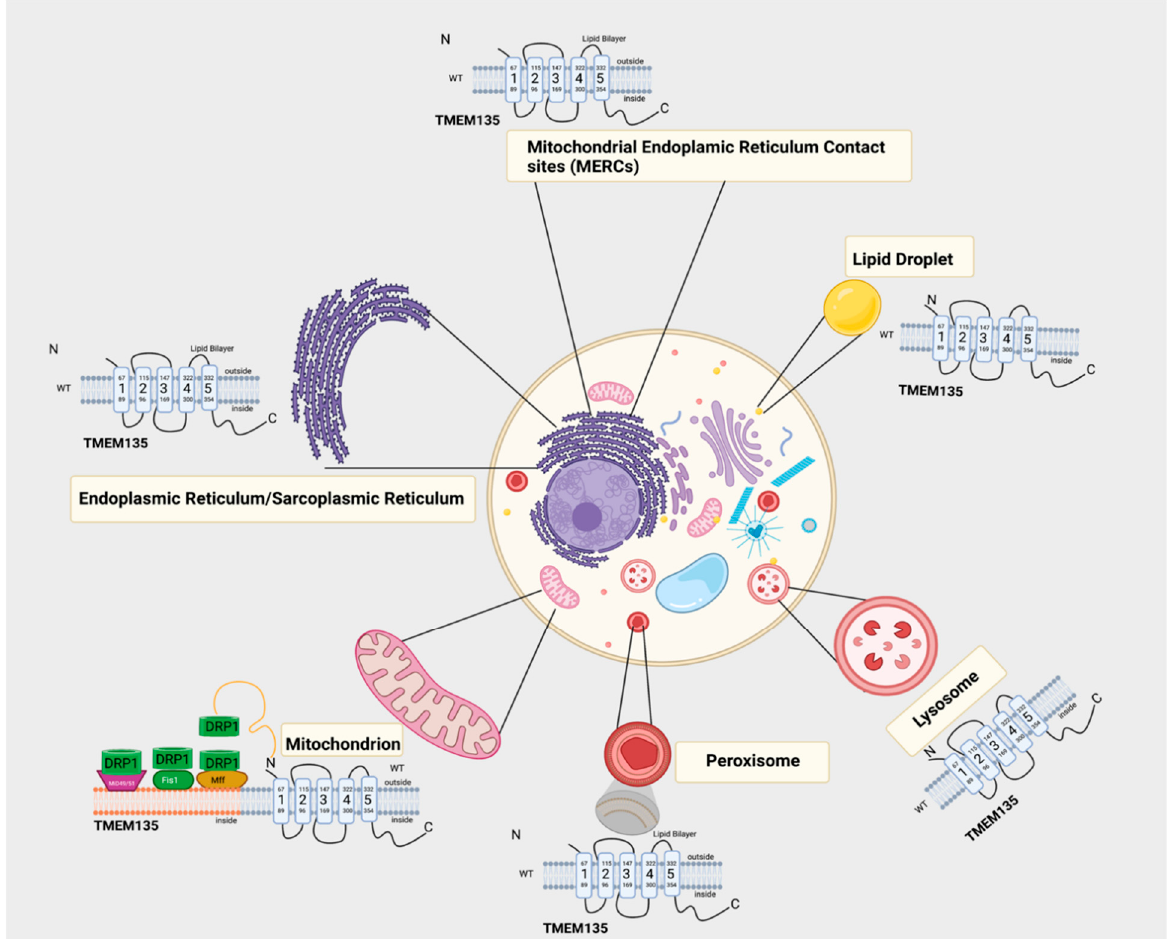
Figure 3. This plausible model of TMEM135 demonstrates the many interactions for TMEM135 in several organelles, including the mitochondria [11] and the mitochondrial endoplasmic reticulum contact sites (MERCs). Additionally, TMEM135 is also a peroxisomal protein [66]. TMEM135 has been shown to co-localize with DRP1 as referenced in Wei Lee et al., 2016 [12]. Here, we show the plausible interaction between TMEM135 and DRP1 in the mitochondria and TMEM135 in the peroxisome [53], lysosome [66], lipid droplets [11], and the endoplasmic reticulum/ sarcoplasmic reticulum (ER/SR) [11]. Figure created with BioRender.com (accessed on 15 June 2021).